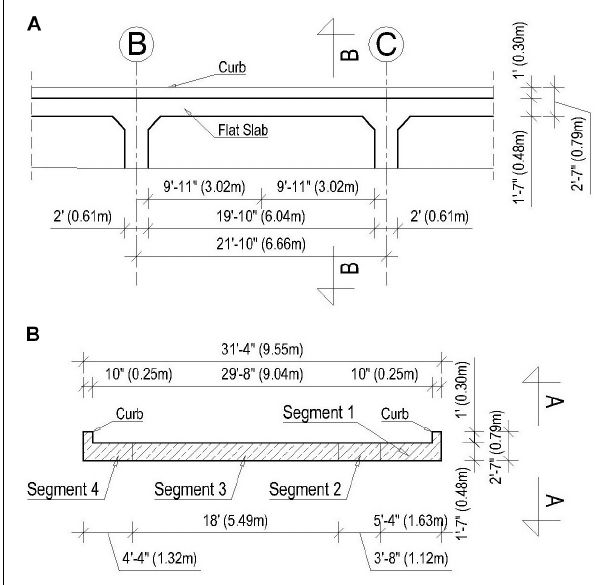
FIGURE 2 | Detailed drawings of the bridge, (A) elevation view A-A, (B) cross-section